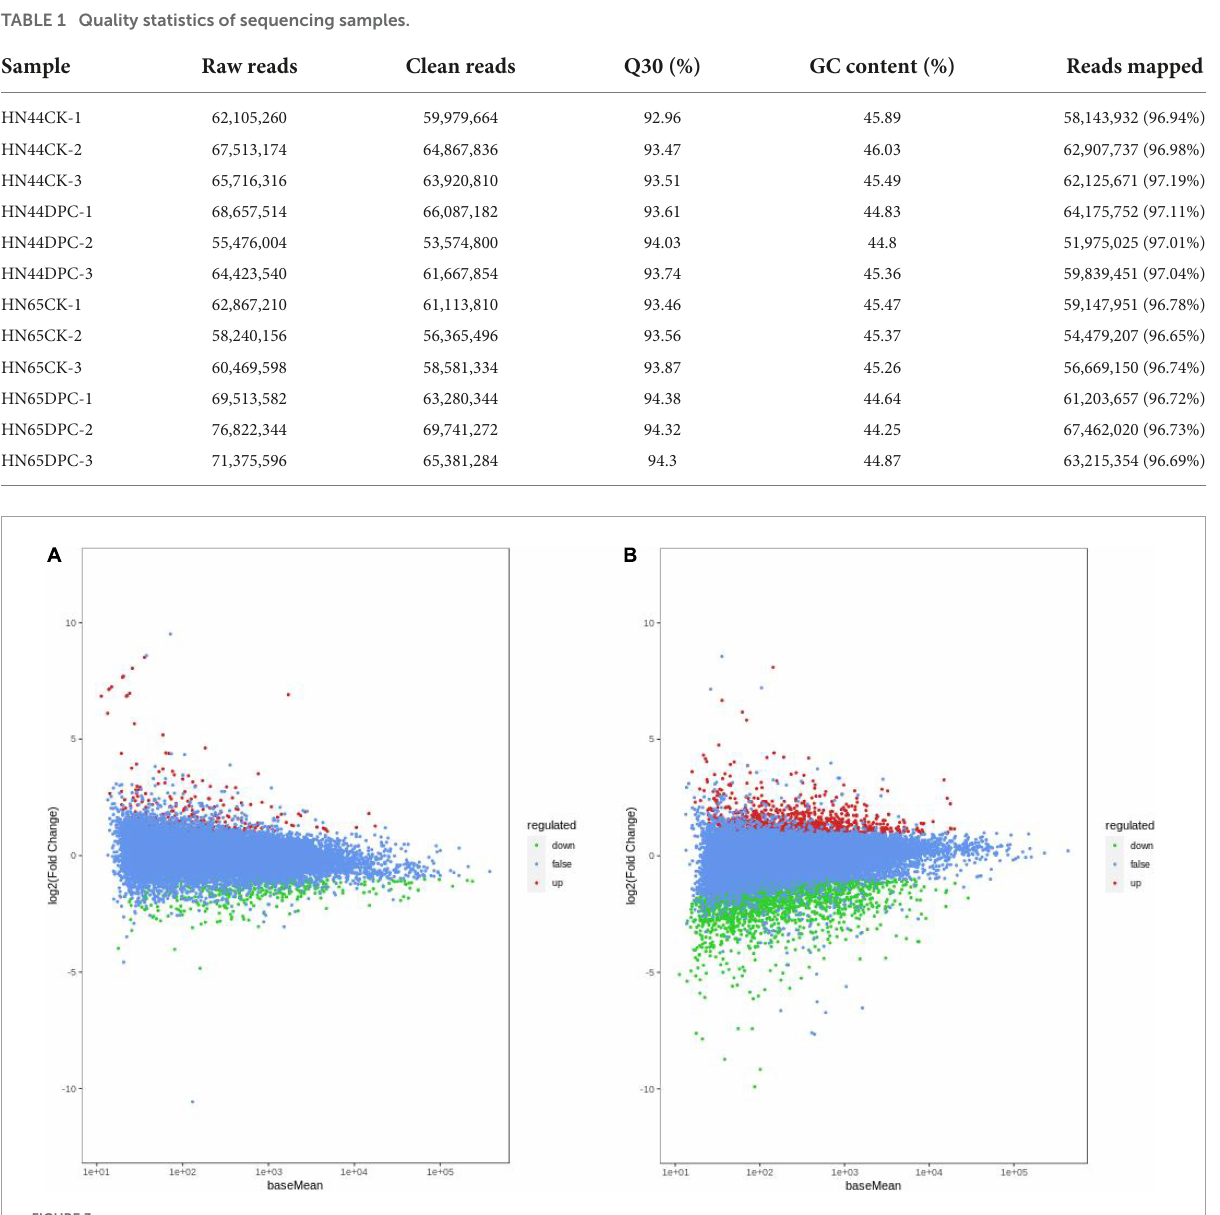
FIGURE3 MA Chart of DEGs. The vertical axis represents the log2FC value, which represents the logarithm of the difference fold (log2 Fold_Change); the horizontal axis represents the average value of gene expression in the two samples; the red points represent the up-regulation of gene expression, the green points represent the down-regulation, and the blue Indicates that there were no significant differences in gene expression. (A) HN44 group; (B) HN65